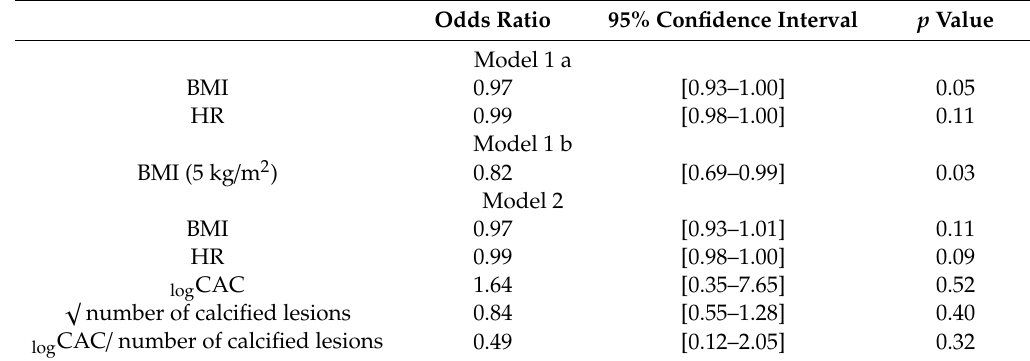
Table 5. Multiple logistic regression models of baseline characteristics and scan demographics and accuracy of cCTA.